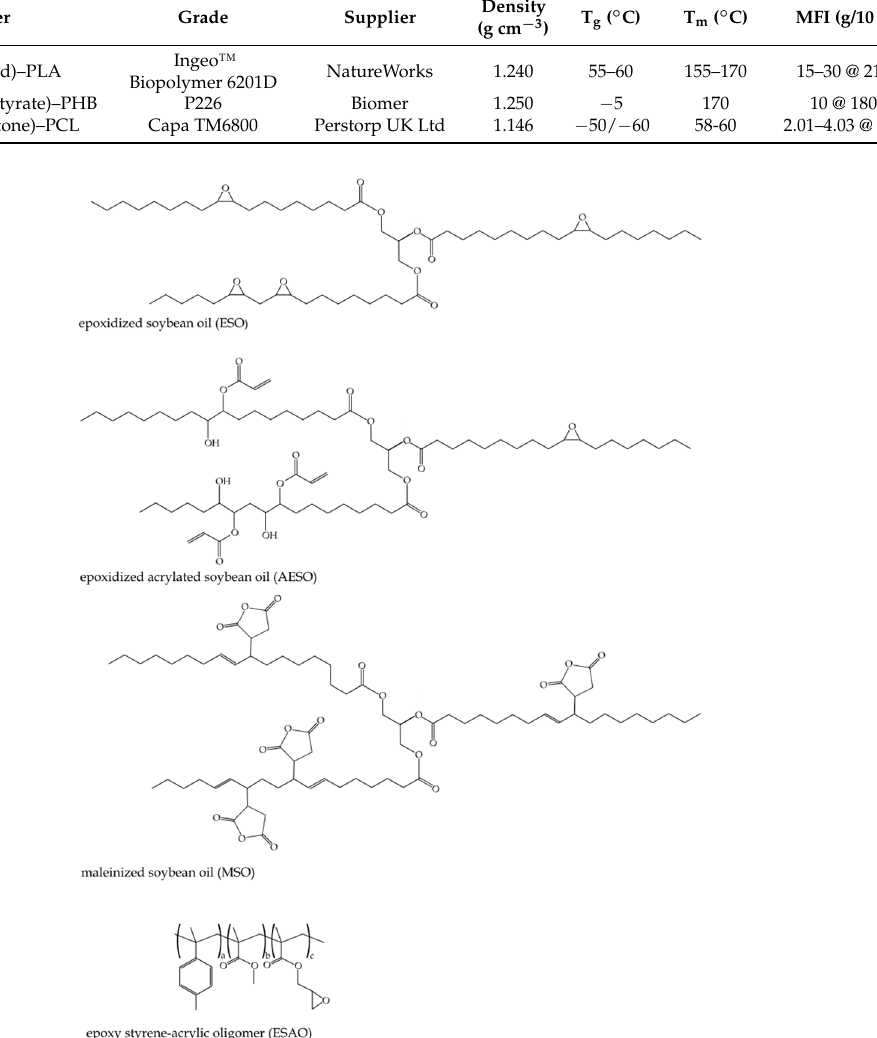
Scheme 3. Schematic representation of the chemical structure of compatibilizers used for ternary PLA 60 /PHB 10 /PCL 30 blends.